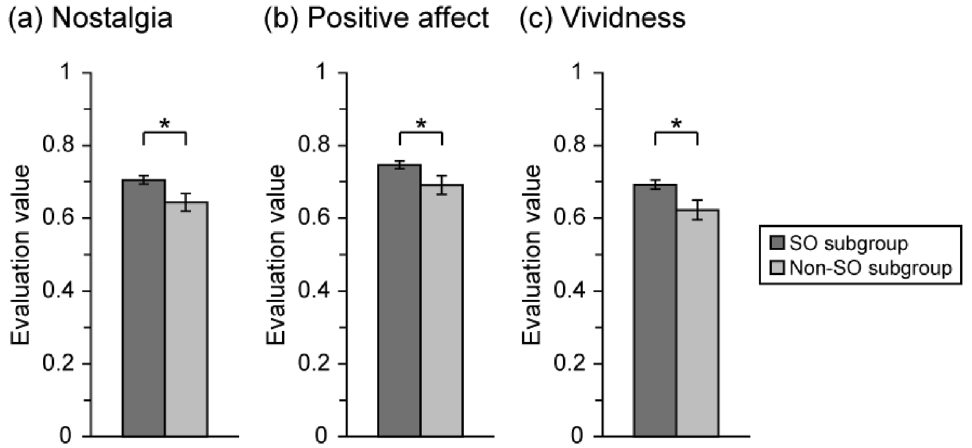
Figure 5. Psychological characteristics of nostalgic vegetable-related autobiographical memories in each seasonality subgroup. Nostalgia ( a ), positive affect ( b ), and vividness ( c ) for nostalgic vegetable-related autobiographical memories in the SO and non-SO subgroups. Unpaired t -test revealed significant differences between the two groups in nostalgia ( t (425) = 2.27, p < 0.05), positive affect ( t (425) = 2.14, p < 0.05), and vividness ( t (425) = 2.28, p < 0.05). Error bar: SE. * p <